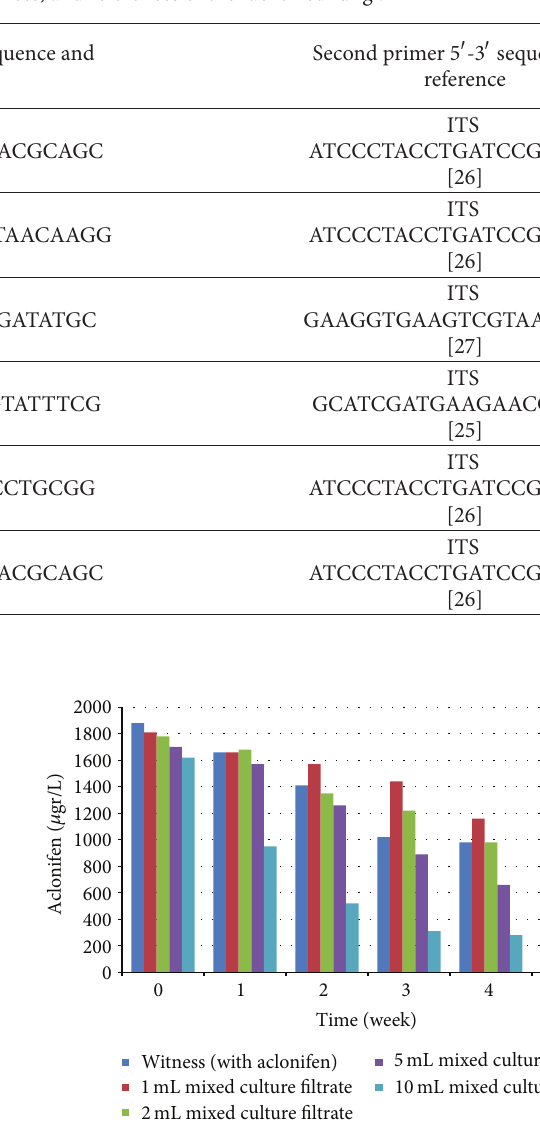
Table 3: First and second primers, sequences, and references of the identified fungi.